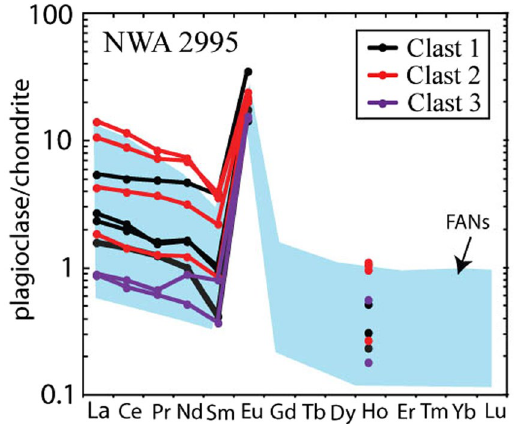
Figure 3. Chondrite normalised REE abundances for plagioclase mineral fragments within NWA 2995, where the chondrite normalisation values are after 61 . Background field for Apollo FAN samples using data collected by ref.